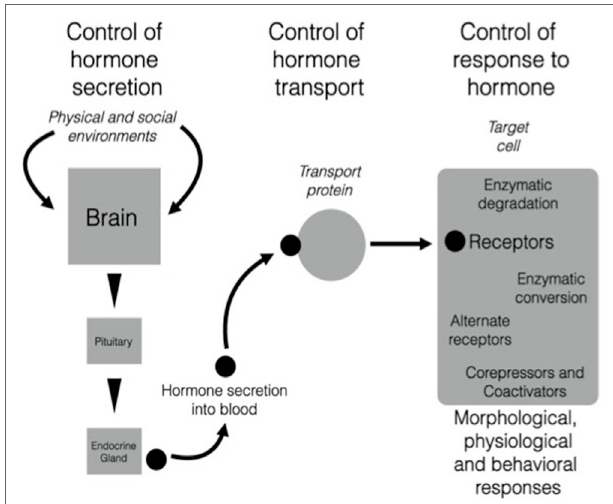
FigUre 1 | There are three components of the action of hormones that can be regulated in diverse ways. The left-hand part of the figure shows the triggering of neural, neuroendocrine, and endocrine cascades that result in production of a highly specific secreted signal. The central part of the figure shows that after secretion into the blood, many hormones (particularly steroids, thyroid hormones, and some peptides) are transported by carrier proteins. Once the hormonal signal reaches the target cell (e.g., a neuron in the brain), it can act in various ways by binding to membrane or nuclear receptors that trigger extremely complex actions in a cell. Note that all three components are sites of regulation that could change daily or seasonally, or vary among individuals, populations, sex, or in response to unique experience of the environment. It is possible that this scheme is highly conserved across vertebrates and that different species modulate different components and still achieve the same behavioral and physiological end points. See text for more details. From Wingfield (10), courtesy of the American Ornithologist’s Union and Wingfield (11), courtesy of Elsevier.